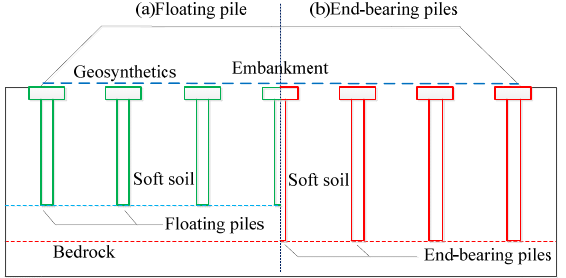
Figure 1. Types of pile-supported embankments: ( a ) End-bearing pile ( b ) Floating pile.